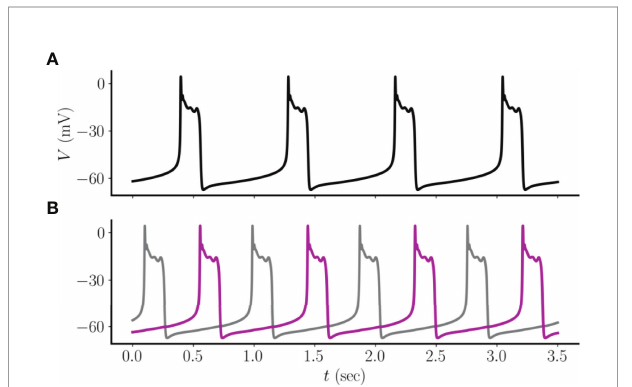
FIGURE 2 | (A) Two electrically coupled pseudo-plateau bursters approach a synchronized asymptotic state when starting from one set of initial conditions. (B) For the same set of parameters, but a different set of initial conditions, the two coupled cells approach a state in which the oscillations are in antiphase. In this example, g c =2